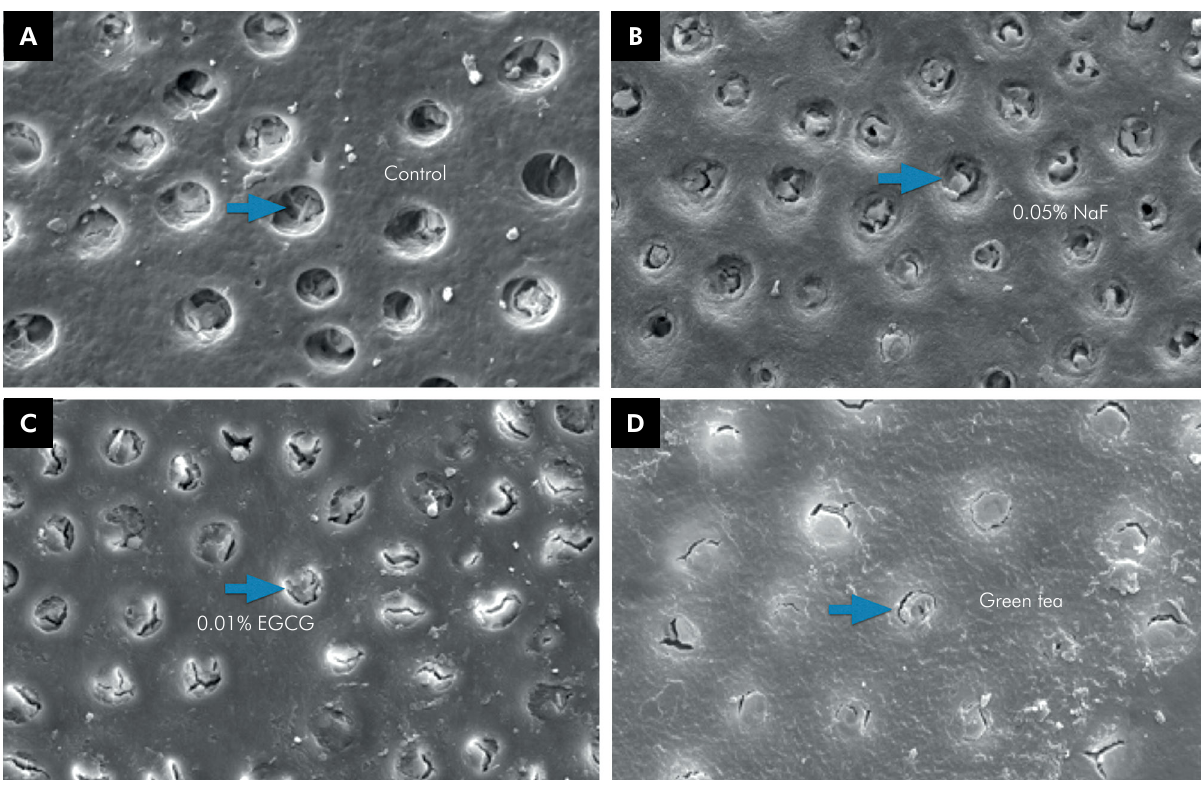
Figure 5. Scanning electron microscopy (SEM) (magnification 4000x) images of eroded dentin that was either not treated (A), or treated with NaF 0.05% (B); EGCG 0.1% (C); and Green tea solution (D). The arrow represents the morphology of the dentinal tubules. Figure 3C and 3D display more obliterated tubules, which differ from the control group (Figure 3A), while figure 3B (NaF) displays an intermediate